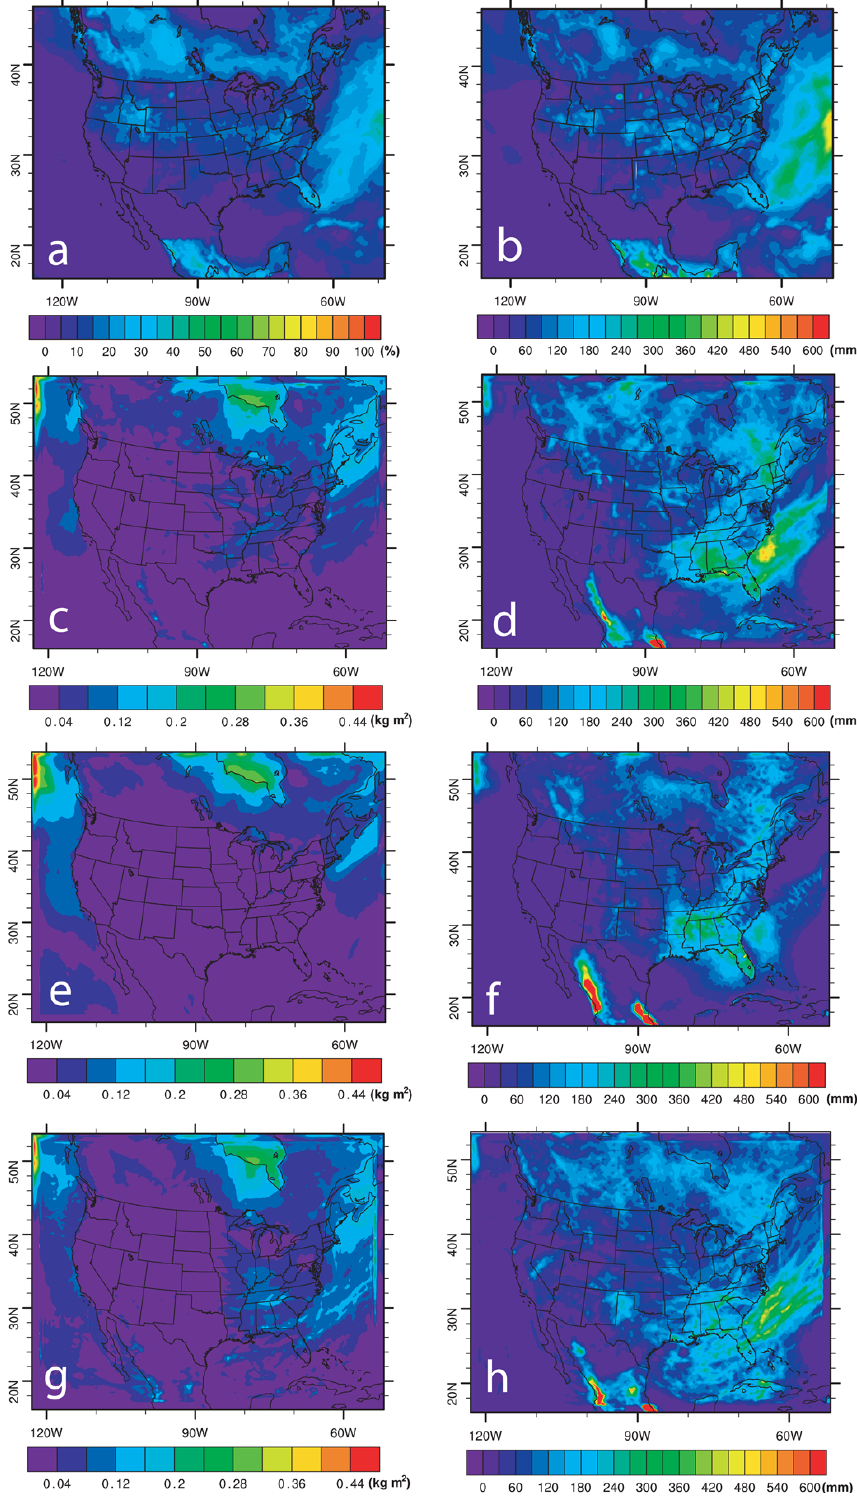
Fig. 4. Comparison of monthly averaged cloud fraction (or cloud water) and monthly accumulated precipitation using WRF and NARR data for July 2009. (a) , (b) NARR; (c) , (d) WRF simulation using spectral nudging; (e) , (f) WRF simulation using grid nudging; (g) , (h) WRF simulation using “grid no